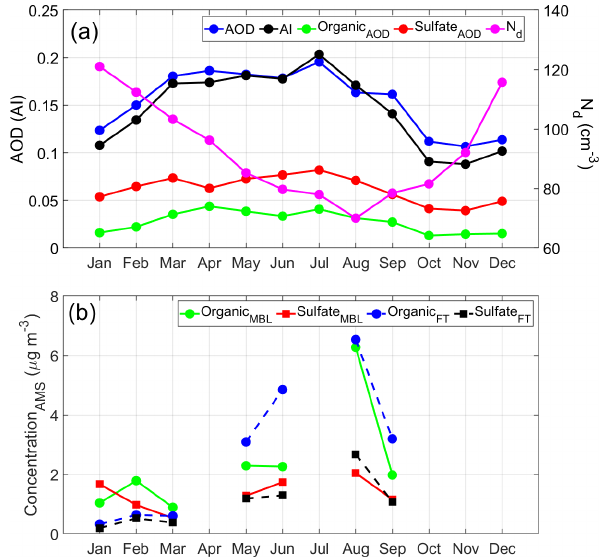
Figure 1. (a) Monthly mean values (January 2013–December 2017) of CERES–MODIS cloud droplet number concentration ( N d ) for low-level clouds (heights below 700hPa), MERRA-2 aerosol in- dex, and MERRA-2 total and speciated (sulfate and organic) aerosol optical depth. Data used apply to the spatial area over the north- western Atlantic where ACTIVATE data were collected (boxes 1–3 in Fig. 2). (b) Monthly mean values of sulfate and organic using ACTIVATE airborne data differentiated by marine boundary layer (BCB/BBL legs) versus free troposphere (ACT/ABL legs); these legs are described in Sect.